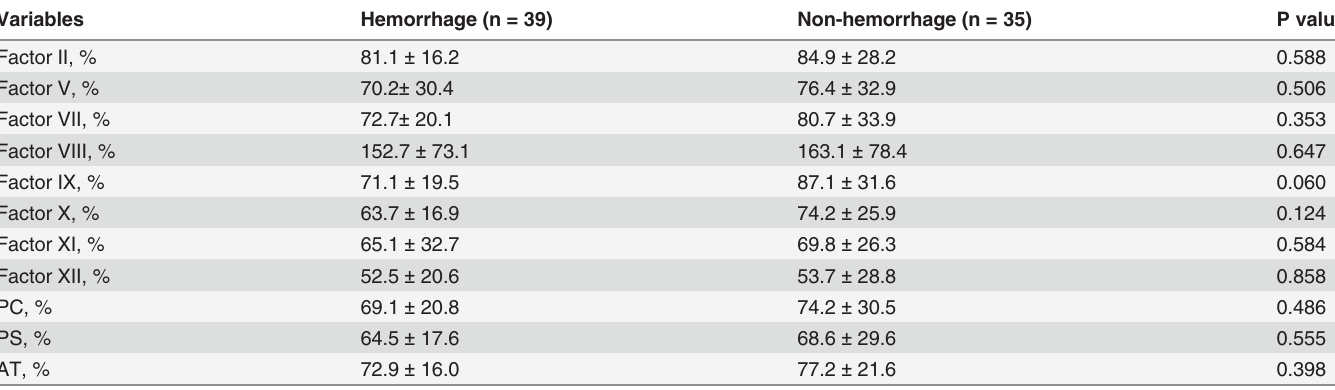
Table 5. Pro- and anti-coagulation factors for patients with and without hemorrhage in the NC-PVT group.